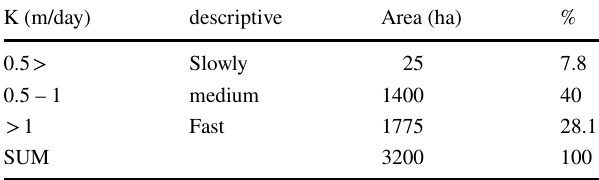
Table 2 Average hydraulic conductivity for area with kiriging method